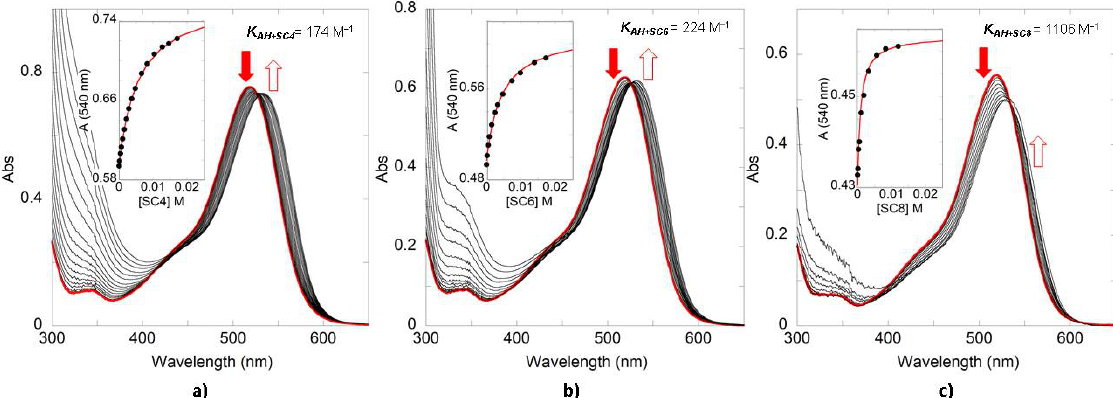
Figure 3. UV-Vis spectral variations of an Oenin solution at pH = 1 upon addition of increasing concentrations of ( a ) SC4 (Oenin = 2.2 × 10 −5 M), ( b ) SC6 (Oenin = 1.8 × 10 −5 M) and ( c ) SC8 (Oenin = 1.6 × 10 −5 M). The inset shows the fitting for the calculation of the association constant with a 1:1 H-G model. Table 1. Association constants K AH+SCn (M − 1 ) for the formation of 1:1 host-guest complexes between p -sulfonated calix[n]arenes and flavylium species of 4 (cid:48) 7-DHF and Oenin. K AH+SCn (M − 1 ) calculated after fitting (Equation (1)) of the data obtained after titration of 4 (cid:48) 7-DHF (1.2 × 10 − 5 M) and